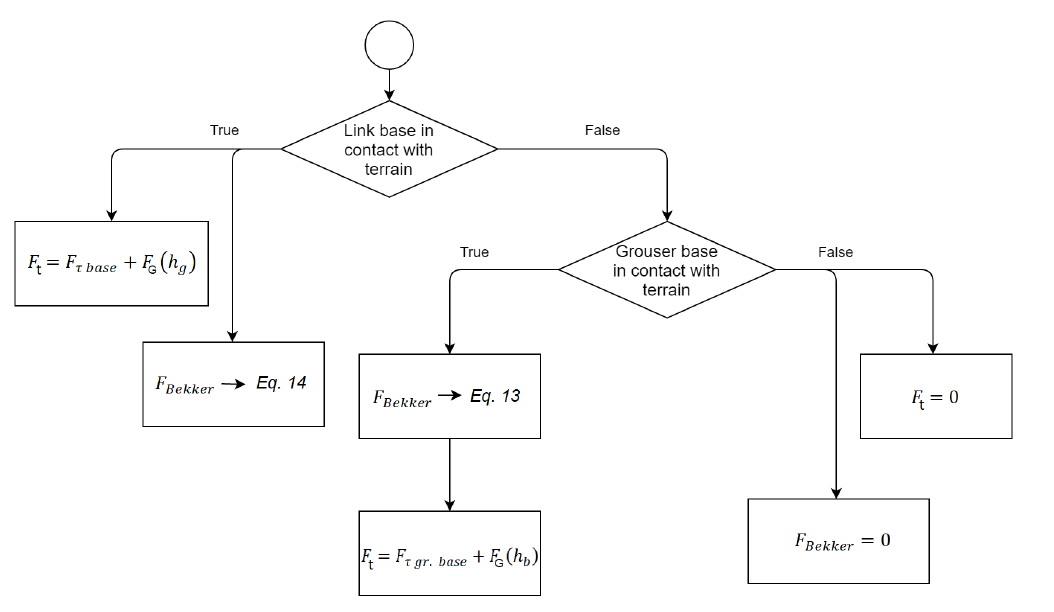
Figure 15. Evaluation strategy for the forces acting on each track link with grouser. Table 3. Grousers MTB routine